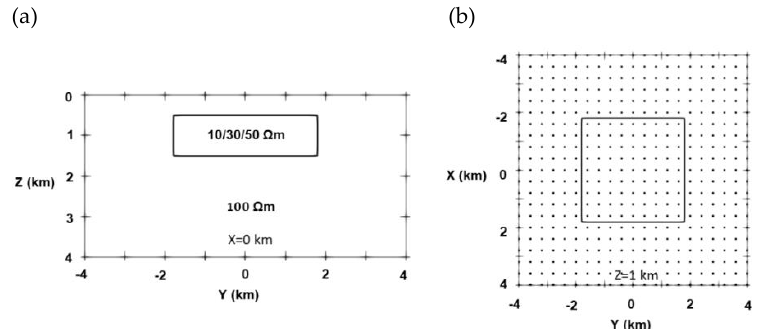
Figure 3. Panels ( a ) and ( b ) show the SM3 model from Cao et al., 2018 at x = 0 km and z = 1 km, respectively. The black dots represent the MT